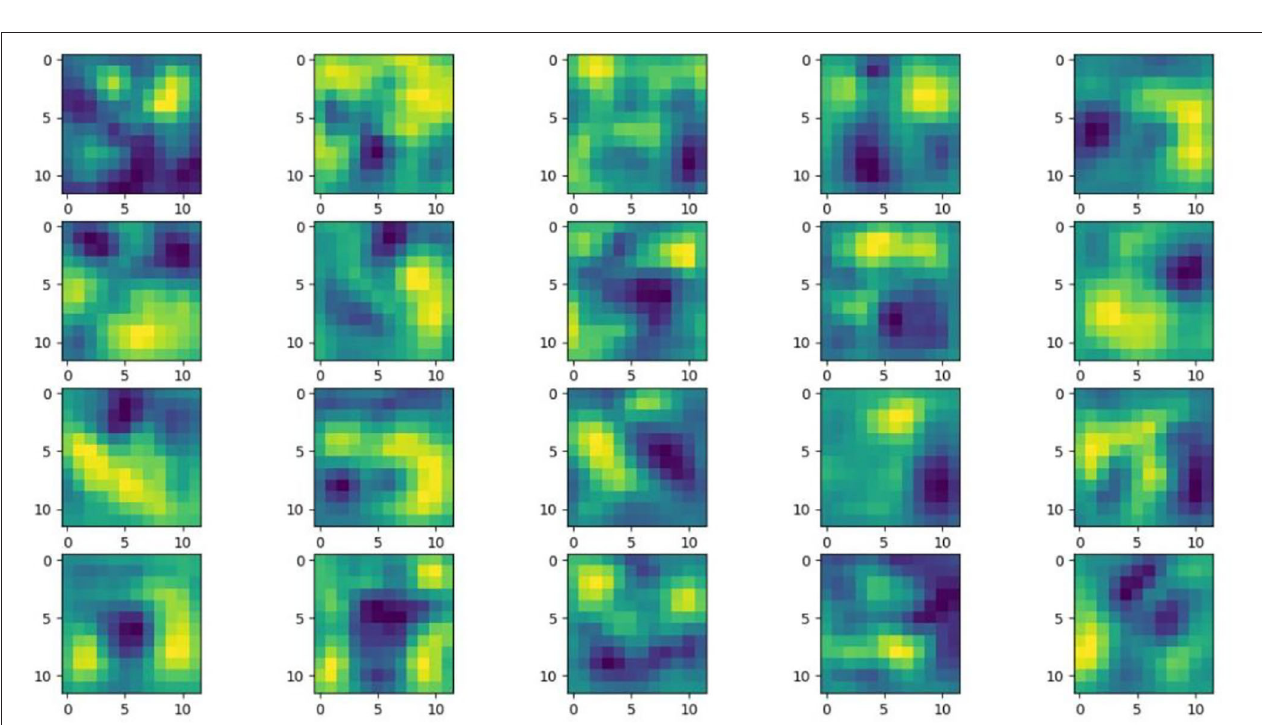
FIGURE 9 | Partial output feature maps of the last